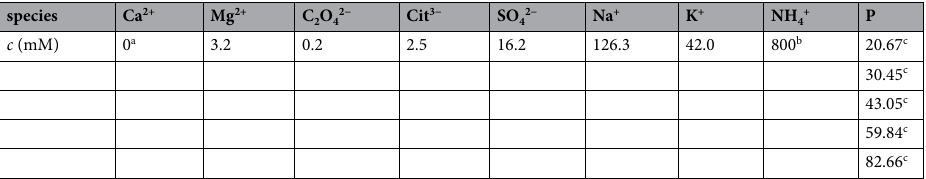
Table 5. Initial concentrations, c , of particular ions taken into account in the HySS calculations. a In this study we used artificial urine with modified composition without calcium chloride dihydrate which results in an initial Ca 2+ concentration of 0 mM. b This amount of NH 4+ results from the assumption that the entire available amount of urea (25 g/l, Table 1) is decomposed to form, inter alia, NH 3 in gaseous form (details in Ref. 48 ). c These are the phosphorus concentrations tested in this study—see Table 2, column 3. Cit stands for [C and results from the presence of trisodium citrate in the artificial urine.